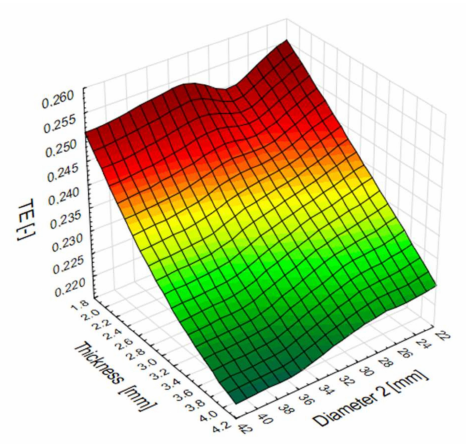
Figure 14. Diagram of the total e ffi ciency (TE) indicator for a specific data obtained in numerical